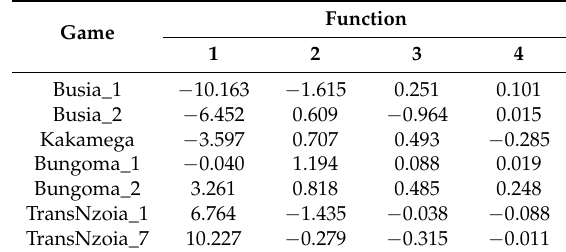
Table A12. Functions of group centroids.